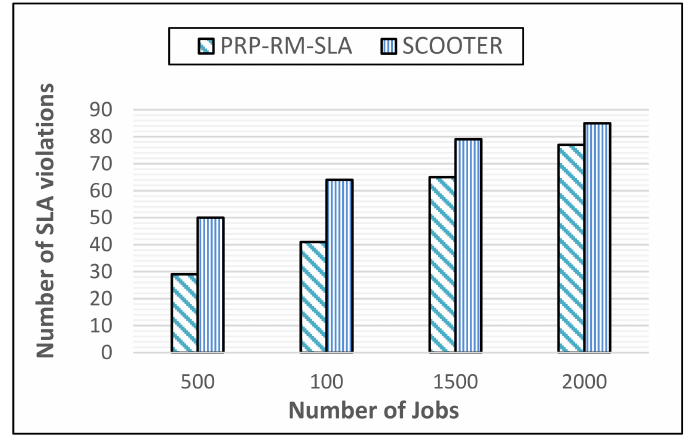
Figure 3. Comparison of results in respect of number of SLA